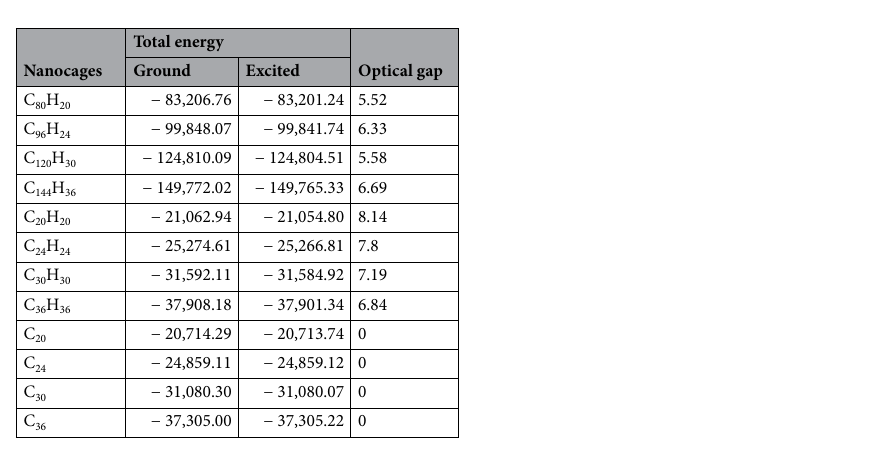
Table 4. Optical gap of the fullerynes and the corresponding fulleranes and fullerenes (in units eV).